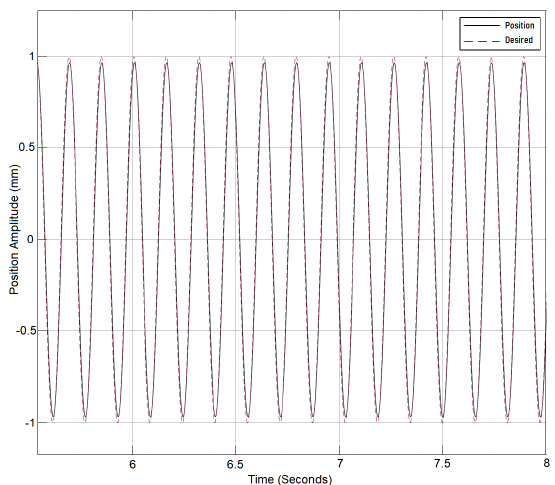
Figure 5. Lyapunov controlled position with reference to sinusoidal wave of 40 rad/s frequency.